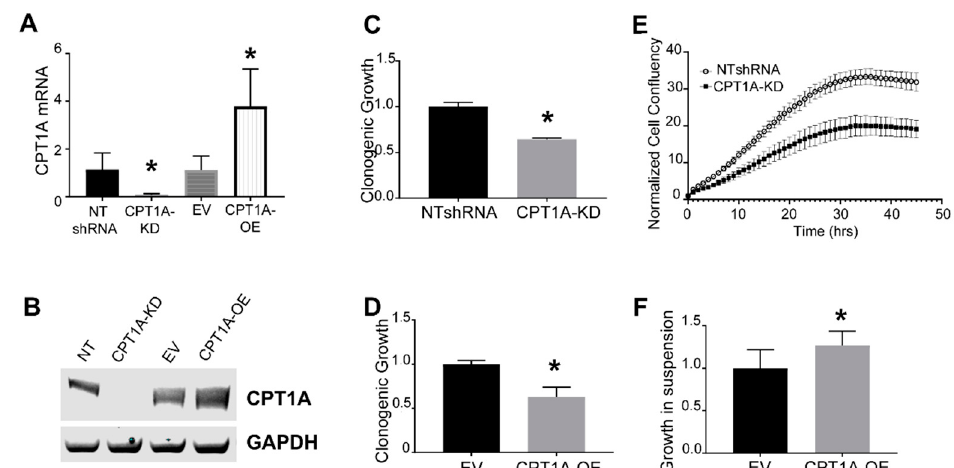
Figure 1. Characterization of C4-2 cells with CPT1A knock-down ( CPT1A -KD) or CPT1A overexpression ( CPT1A-OE ). ( A ): CPT1A mRNA levels were measured in CPT1A knockdown and overexpressing C4-2 cells using qRT-PCR, (n = 4 per group. Students t -test; * p = 0.002 for KD and * p = 0.007 for OE). Each measurement was normalized to corresponding RPL13A mRNA. ( B ): Representative western blots showing the protein level of CPT1A in CPT1A- KD, CPT1A-OE and their respective controls (NTshRNA, EV) in C4-2 cells. GAPDH was used as loading control. ( C , D ): Clonogenic growth of CPT1A -KD ( C ) and CPT1A -OE ( D ) compared with their respective controls (n = 4 per group, Students t -test. * p < 0.01 vs. controls). ( E ): Scratch wound / migration assay on Essen IncuCyte ® . Cell migration was measured by cell confluency (n = 10 per group). The scratch area at time 0 was set to 1. Representative images are in Supplementary Figure S1A. Similar experiments with CPT1A -OE cells did not yield usable data, as they did not adhere firmly, resulting in nonuniform scratch lines that could not be measured reliably. ( F ): Growth assay in suspension conditions with CPT1A -OE cells and control cells. CPT1A -OE and control EV cells were plated in low-adherence plates in complete media with serum for 14 days; n = 8 per group, * p = 0.014 vs. control. Representative images in Supplementary Figure S1B.